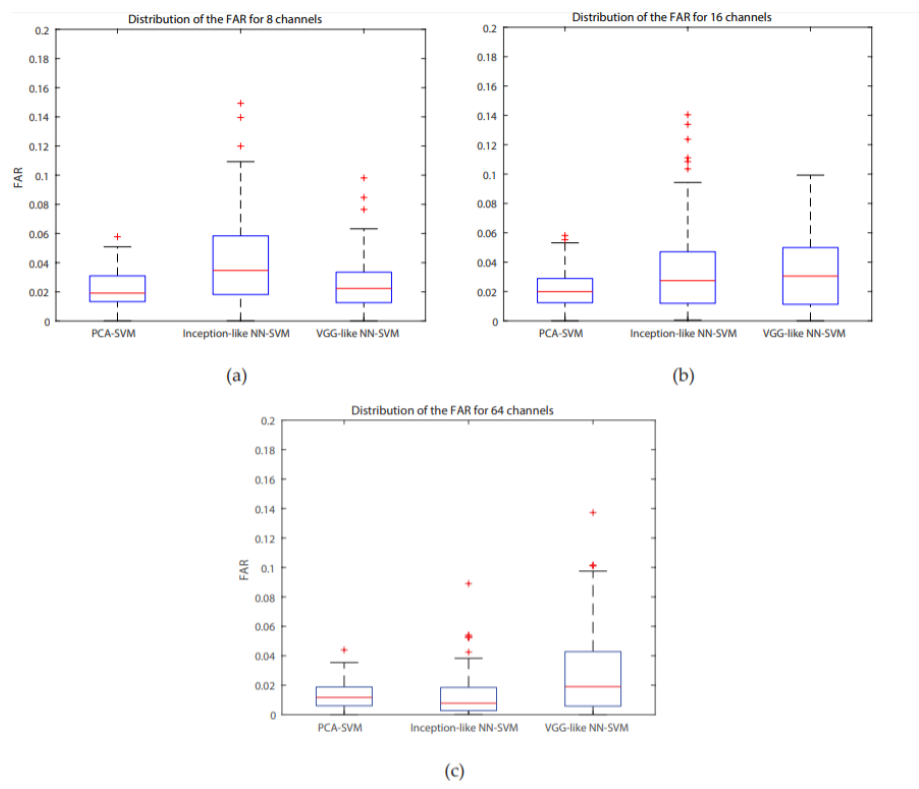
Figure 6. Distribution of FAR across subjects for the PCA ‐ SVM, inception ‐ like NN ‐ SVM, VGG ‐ like